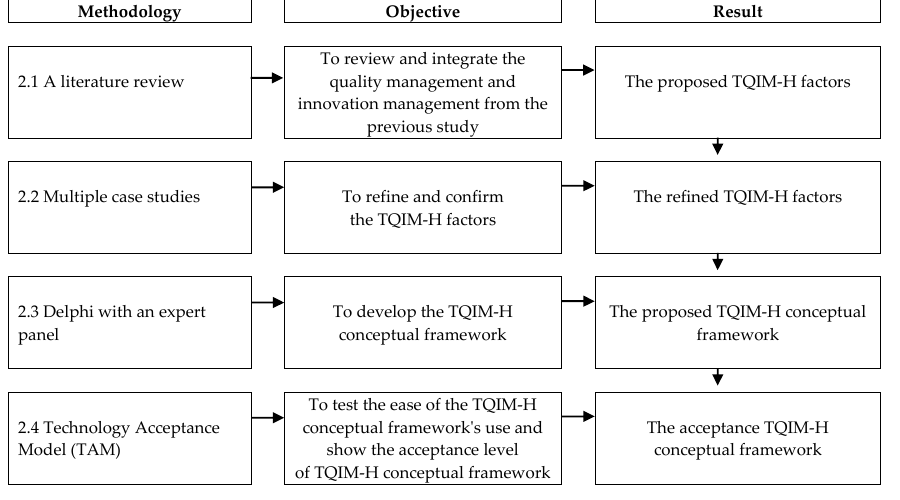
Figure 2. Steps of process methodology .